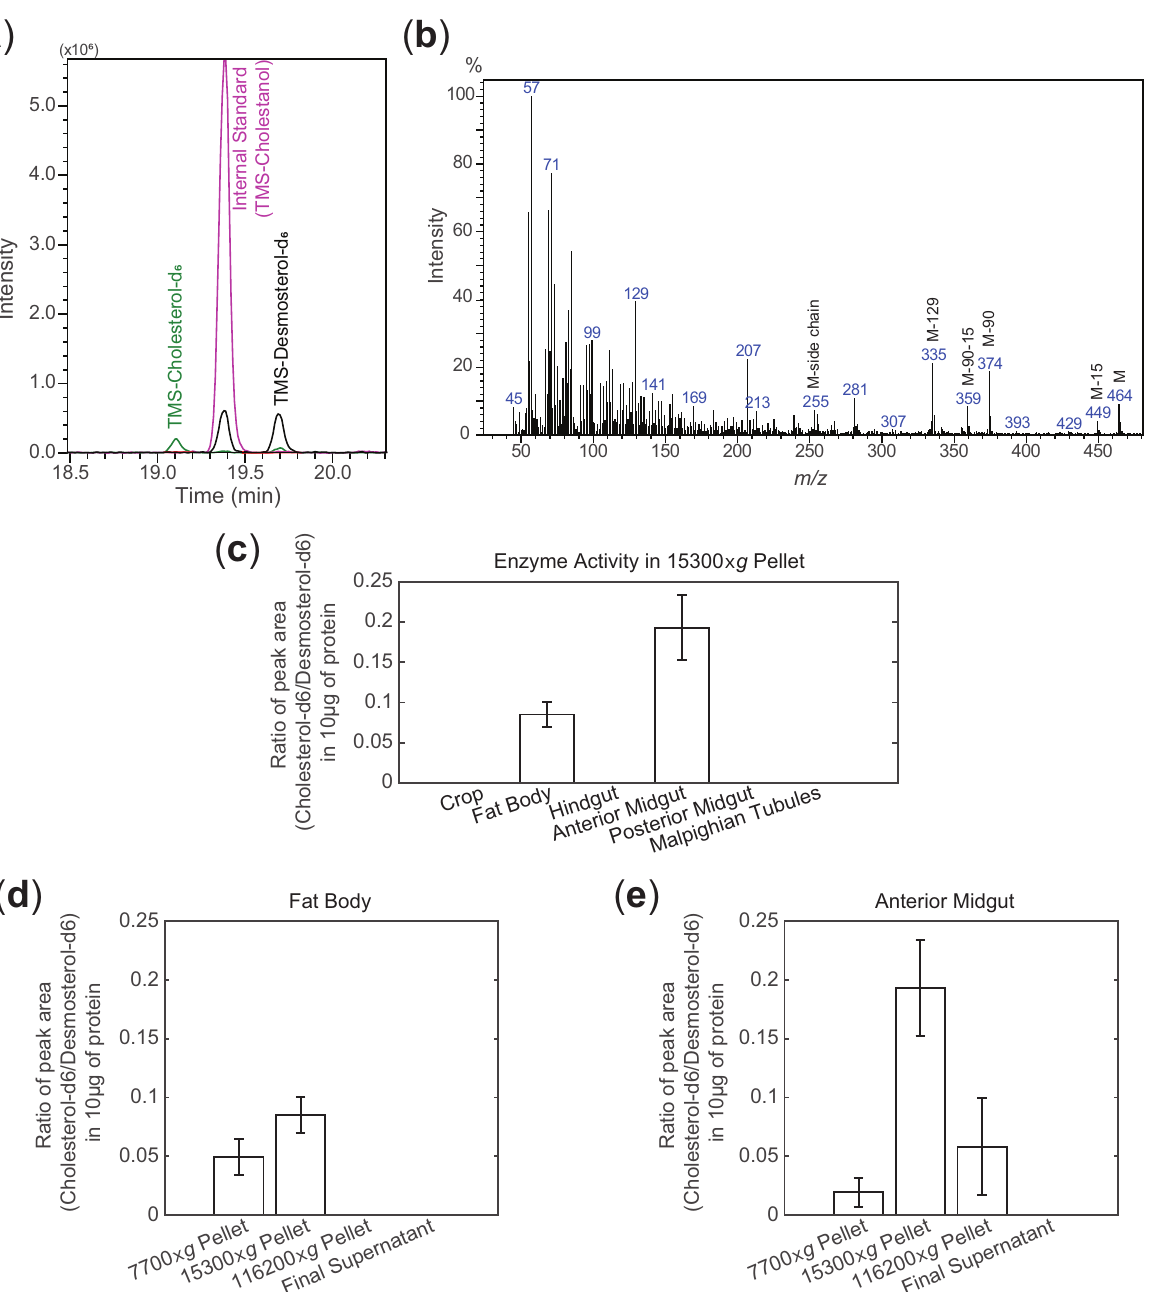
Figure 4. Examination of DHCR24 activity in fat body and anterior midgut. ( a ) Chromatogram of parent ions of TMS- cholesterol-d6 ( m/z 464), TMS-cholestanol as an internal standard ( m/z 460) and TMS-desmosterol-d6 ( m/z 462). ( b ) Mass spectrum of cholesterol-d6 detected in the reacted mixture. The parent ion of cholesterol-d6 is at m/z 464 (M) and the characteristic fragment ions, at m/z 449 (M-15), 374 (M-90), 359 (M-90-15) and 335 (M-129), are derived by the loss of trimethylsilanol (TMSOH) (M-90), loss of methyl group (M-15), loss of both TMSOH and methyl group (M-90-15) and loss of the characteristic of 3 β -hydroxy-5-ene steroids (M-129), respectively (Table S2). ( c ) The enzyme activity in the fraction that exhibited the strongest enzyme activity in different tissues. ( d , e ) The intensity of GbDHCR24 activity in fat body and anterior midgut was measured by the peak area ratio of cholesterol-d6 to desmosterol-d6 in four ultracentrifugal fractions, 7700 × g -pellet fraction, 15,300 × g -pellet fraction, 116,200 × g -pellet fraction and final supernatant ( n = 5–12). Data are presented as mean ±